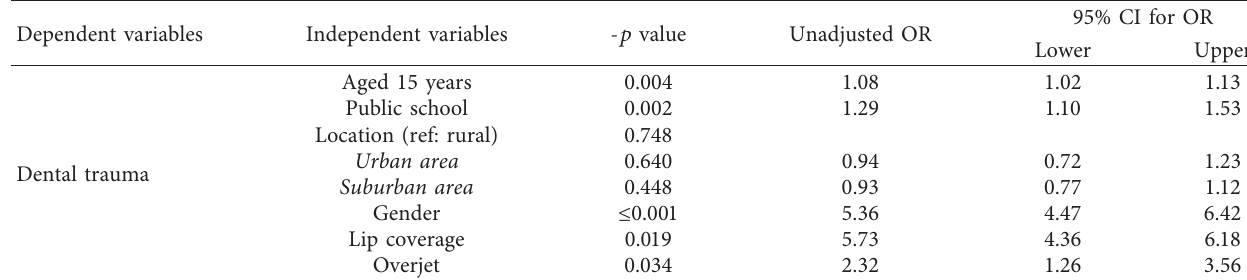
Table 2: Logistic regression analyses of the factors associated with dental trauma.